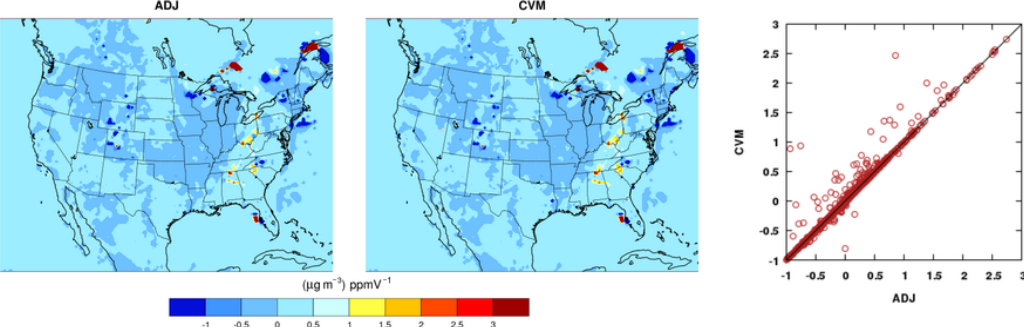
Figure 4. Evaluation of all aerosol subprocesses with the ADJ (adjoint) against the CVM (complex variable method) sensitivities of the final concentrations of an accumulation-mode aerosol species ASO4J (µgm − 3 ) with respect to the initial concentrations of NH3 (ppmV) from a 1d test run. The perturbation size is